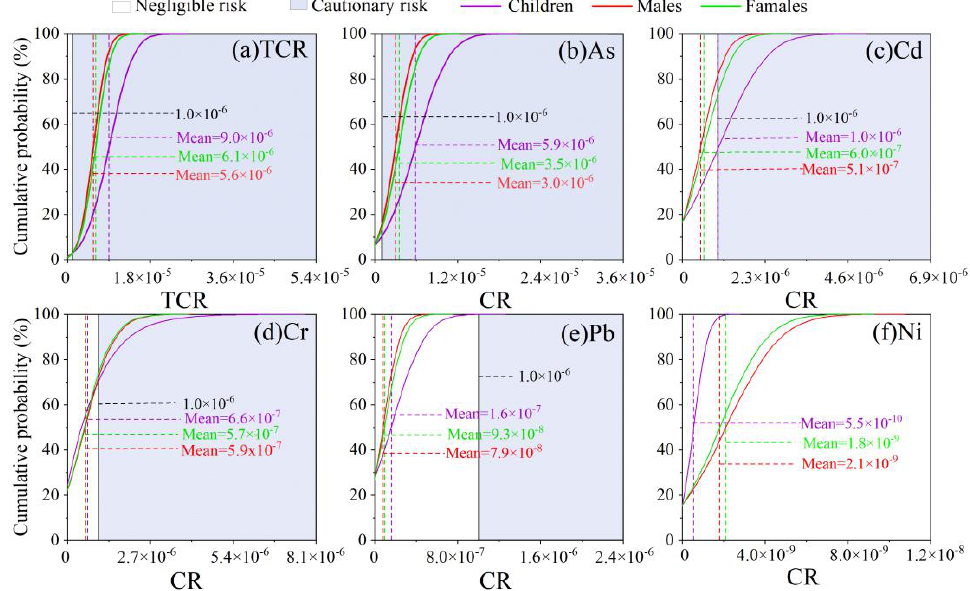
Figure 7. Cumulative probability of carcinogenic risk (CR) and cumulative probability of total carcinogenic risk (TCR) for trace metals in road dust from Guangzhou. Table 3. Carcinogenic risks of trace metals in road dust using total and bioaccessible content. The acceptable threshold is 1.0 × 10 − 6 .